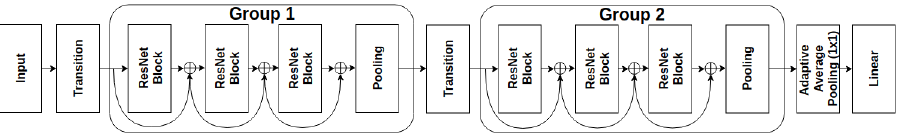
Figure 2. An example decoded network where the model configurations, i.e., the number of groups, the number of blocks per group and the contents of each group (e.g., the kernel size of each ResNet block, the number of channels and the pooling type for each group), are embedded in the encoding